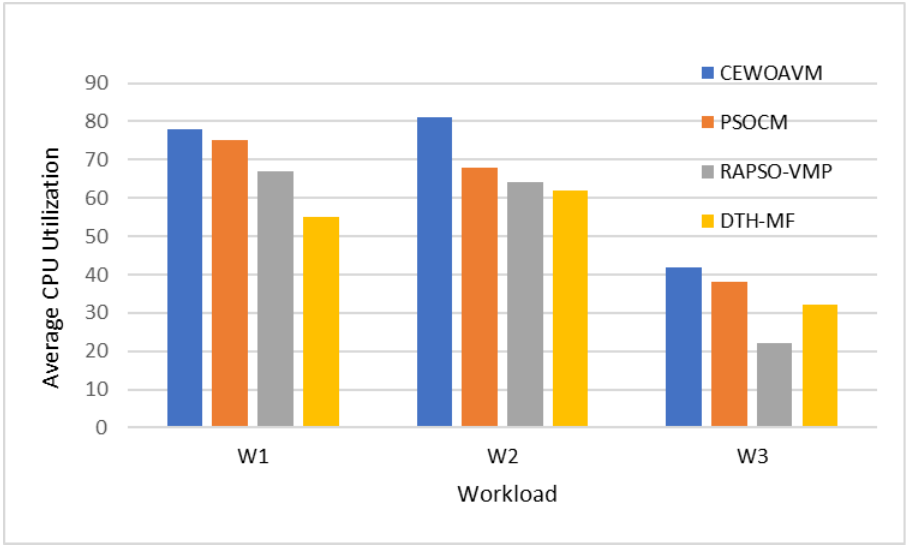
Figure 5. Comparison analysis of average CPU utilization.